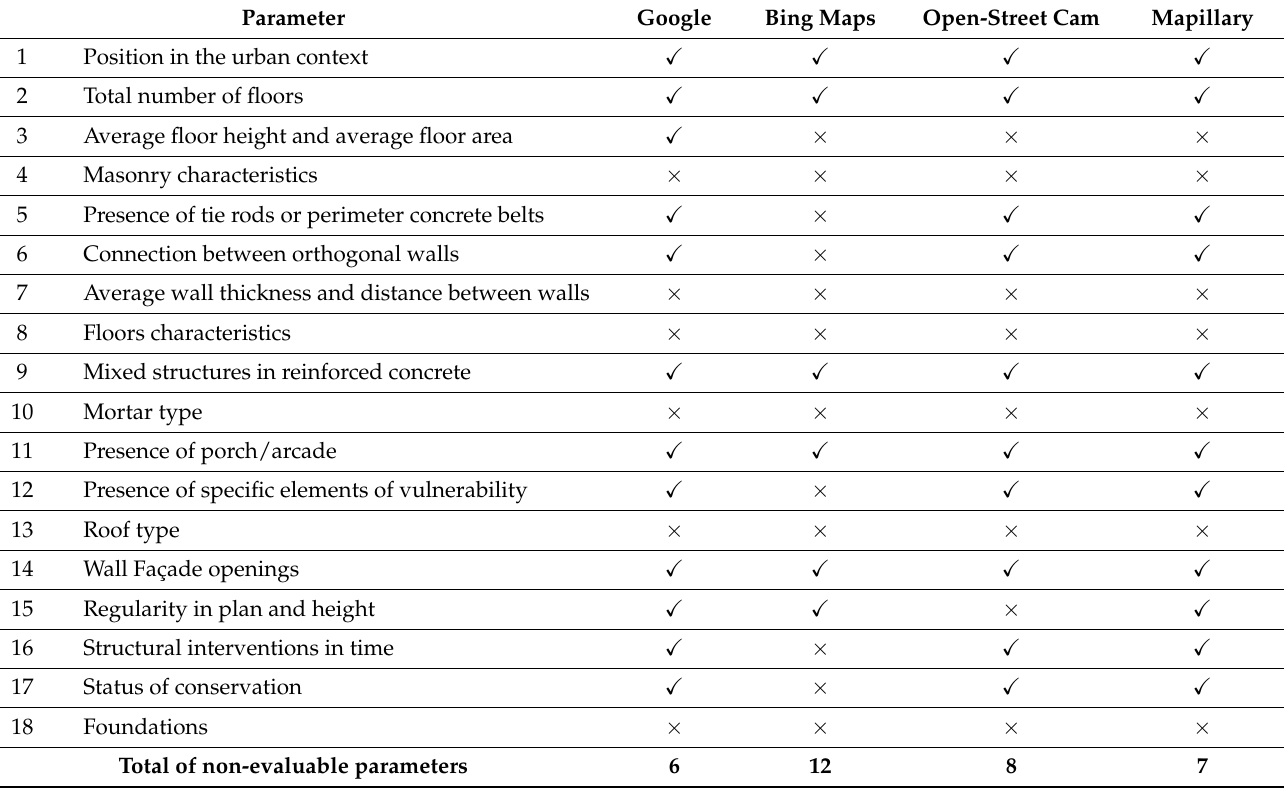
Table 3. Comparison of the web-mapping platforms considering the parameters that can be consulted on each